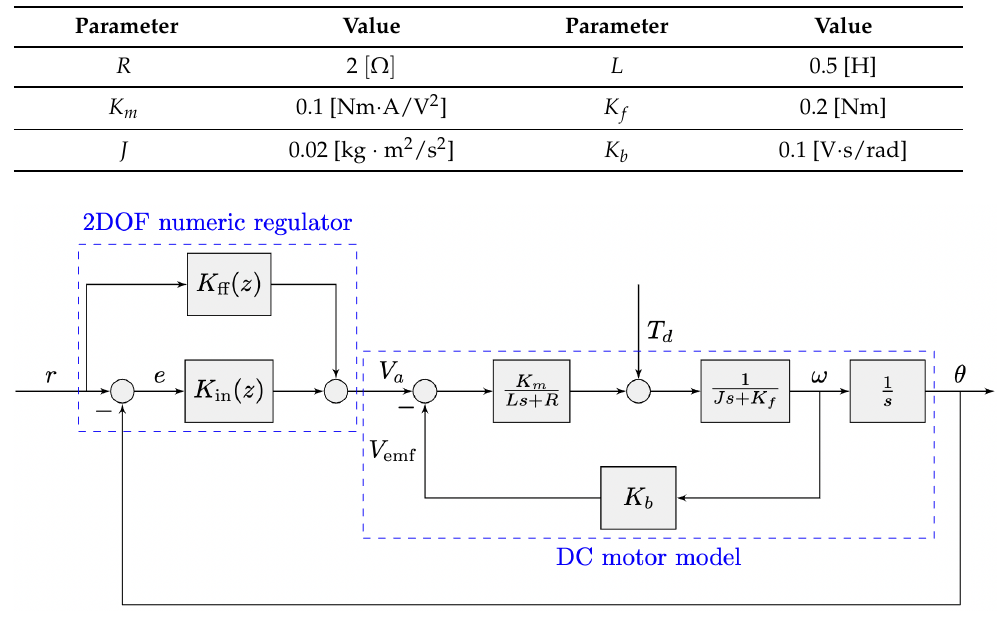
Figure 5. Closed-loop two-degree-of-freedom (2DOF) position control structure for the DC motor system with a control voltage input V a and a disturbance load torque T d . The 2DOF structure has an inner-loop component K in designed for disturbance rejection and a feedforward component K ff for good servo